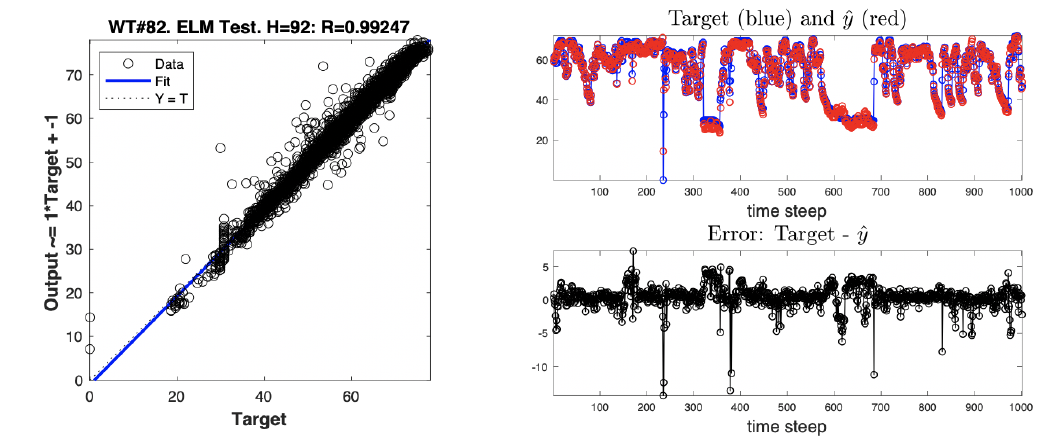
Figure 10. Test of the selected model ( H = 92) for the WT#82. ( Left ) the regression plot using all the test data. ( Right ) from a temporal window where the target ˆ y ( top ) and the error ( bottom ) can be observed in more detail.